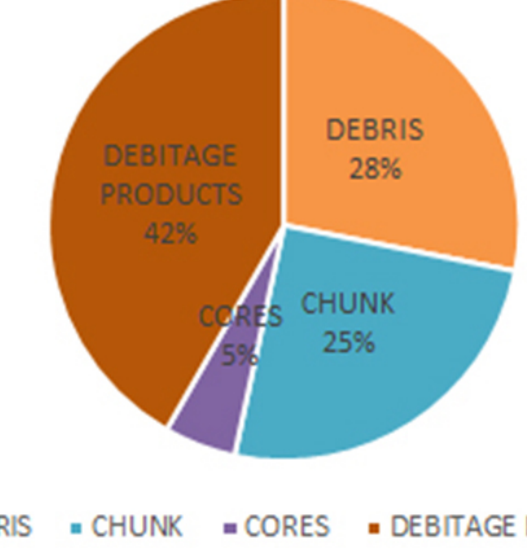
Figure 3. Lithic assemblage that conforms the collection of Tajo de